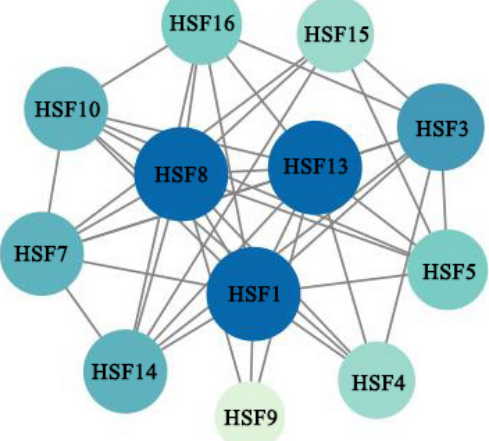
Figure 12. Interaction network of HSF proteins in M. sativa . Nodes represent proteins; central nodes are indicated in blue, and black lines indicate interactions between nodes.